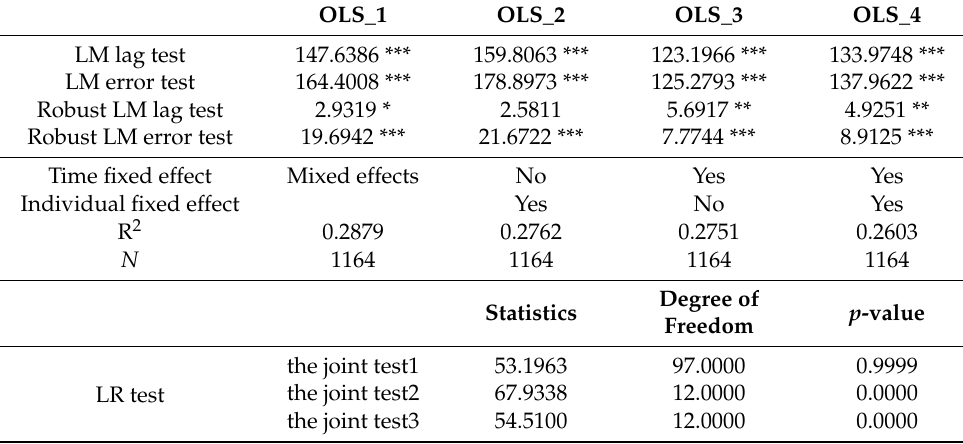
Table 2. LM and LR test in panel data